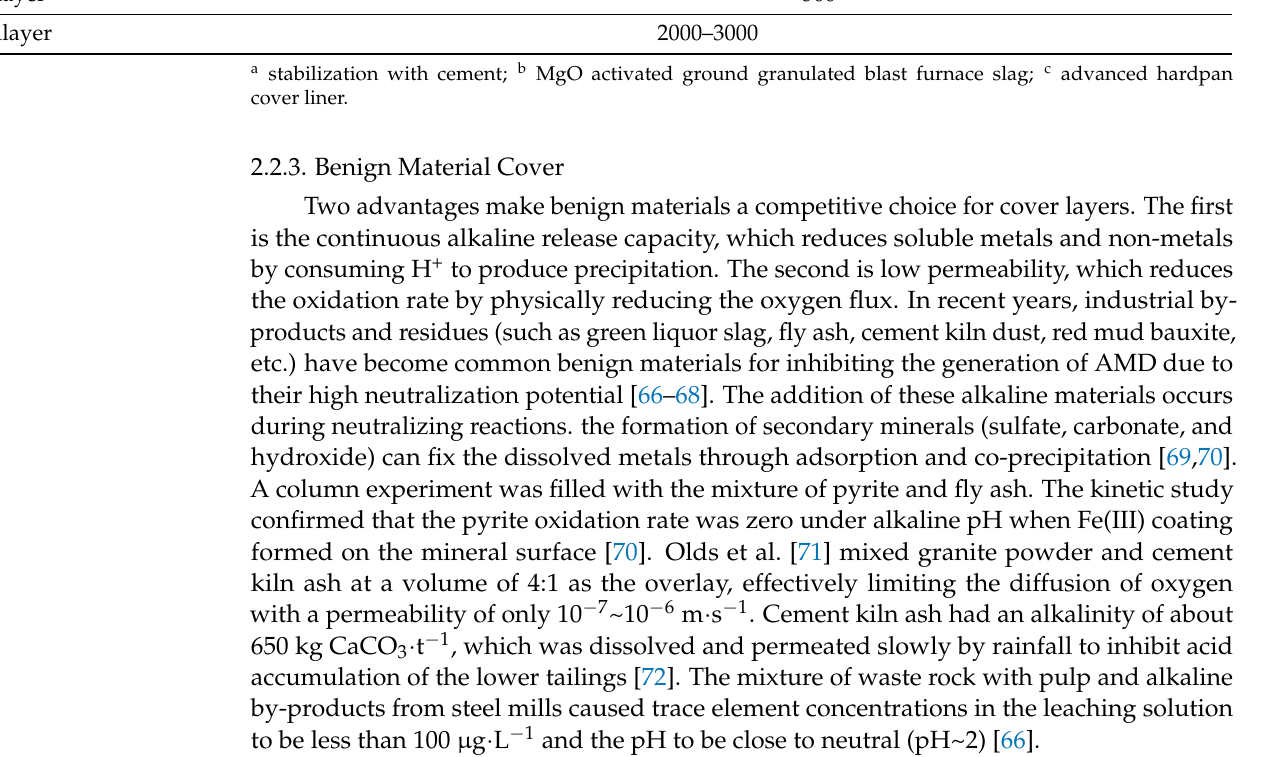
Normalized Cluster Value